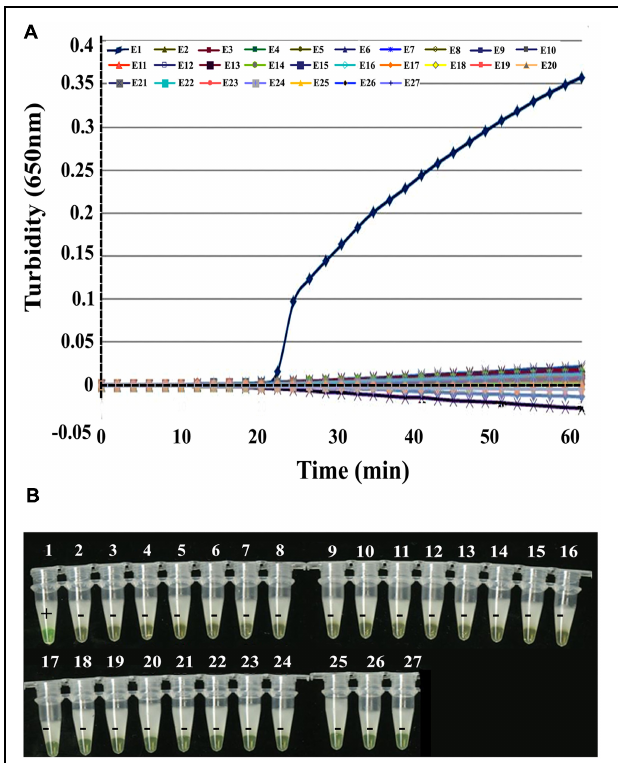
FIGURE 2 | Specificity of EBOV NP detection by RT-LAMP. (A) Turbidity was monitored and recorded every 6 s by a Loopamp real-time turbidimeter at 650 nm. (B) Visual detection using a calcein fluorescent detection reagent. Lane 1, positive control (artificial EBOV RNA); lane 2, negative control (double-distilled water); lane 3, Sudan EBOV (artificial Sudan EBOV RNA); lane 4, MARV (artificial MARV RNA); lane 5, SARS coronavirus; lane 6, H7N9; lane 7, H1N1; lane 8, H2N3; lanes 9–12, human parainfluenza viruses (PIV) 1, 2, 3, and 4; lanes 13–15, adenoviruses (ADV; serotypes 3, 5, and 55); lanes 16 and